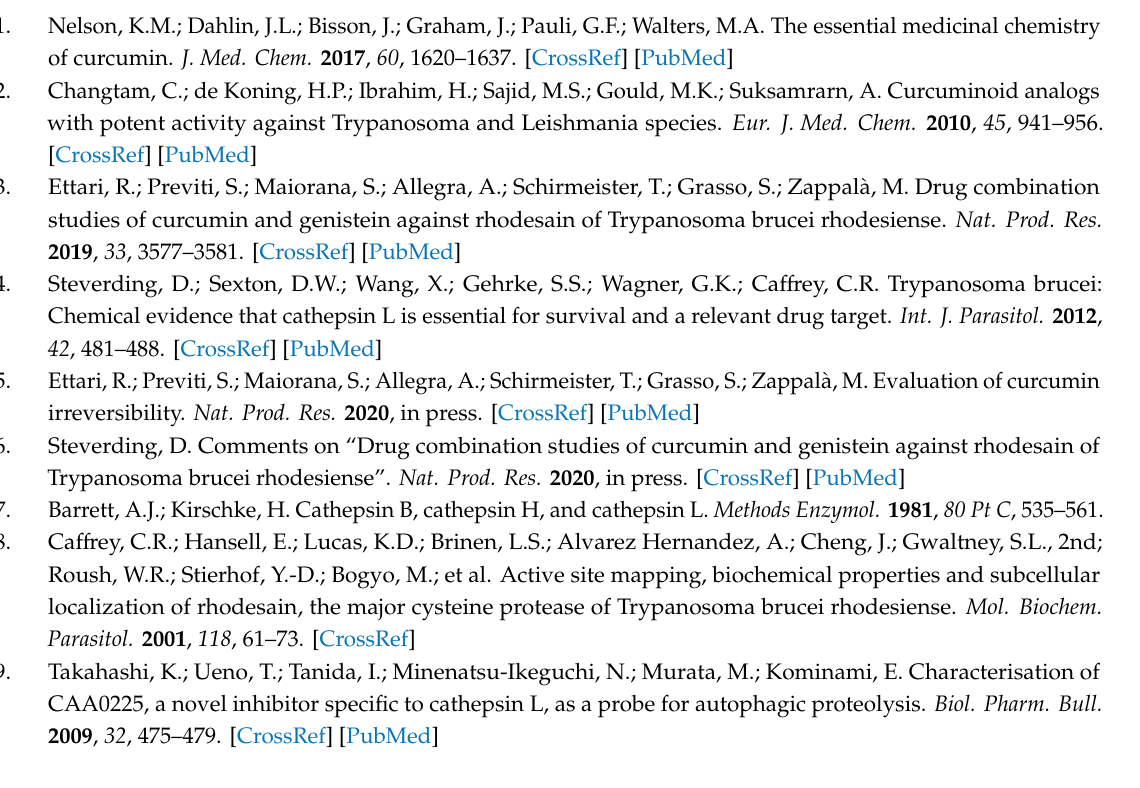
Figure A1. Curcumin (100 nmol) was mixed in 1 mL of 100 mM citrate, pH 5.0 containing 0.1%, 1% and 10% DMSO, respectively. Then, 200 µ l of the solutions were pipetted into wells of a 96-well plate and the absorbance read at 450 nm using a BioTek ELx808 microplate reader, Winooski, Vermont, USA. Note that curcumin has an absorption maximum at around 430 nm in di ff erent polar solvents [12]. A blank (0.035) recorded with 200 µ L of 100 mM citrate, pH 5.0 was subtracted from the absorbance values. With increasing DMSO concentration, the absorbance of the solution also increased indicating that more and more curcumin was being dissolved. In the presence of 10% DMSO, four and five times more curcumin was dissolved than in the presence of 1% and 0.1% DMSO, respectively.